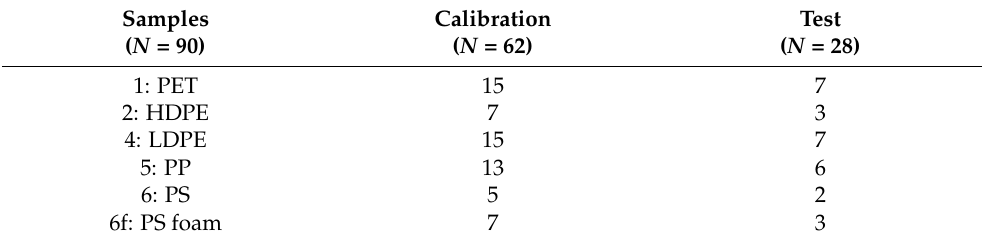
Table A1. Composition of the calibration and test sets for the plastic classification experiment.